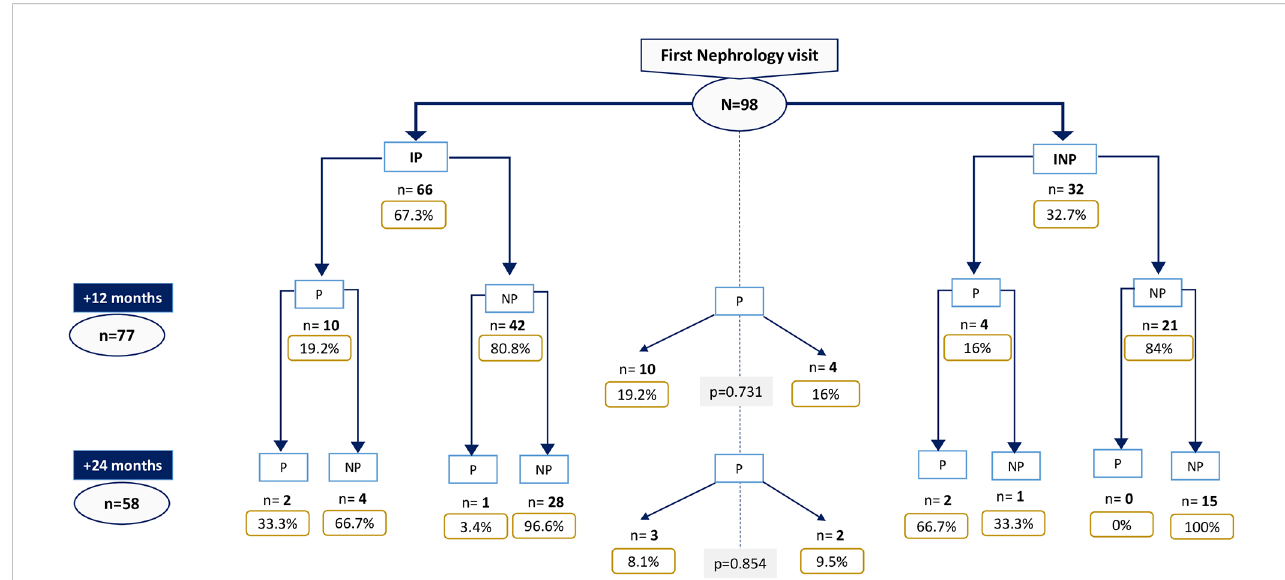
FIGURE 3 Progressor patients throughout follow-up among those with fi rst Nephrology vist eGFR<30 mL/min/1.73m2. IP, Initial-progressors; INP, Initial non- progressors; P, Progressors; NP,